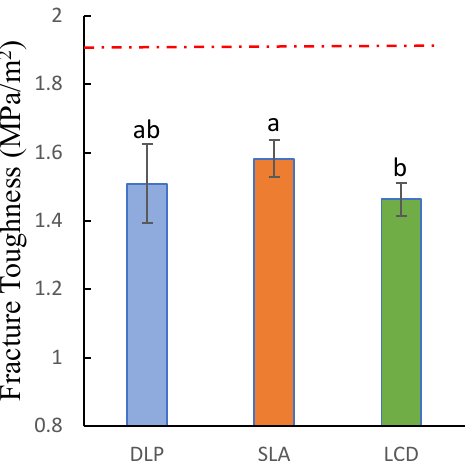
Figure 6. Flexural strength and modulus of 3D-printed denture base resin specimens: ( a ) flexural strength; ( b ) flexural modulus. Similar letters indicate insignificant differences. Red dotted lines in- dicated the minimum requirements according to ISO standards.